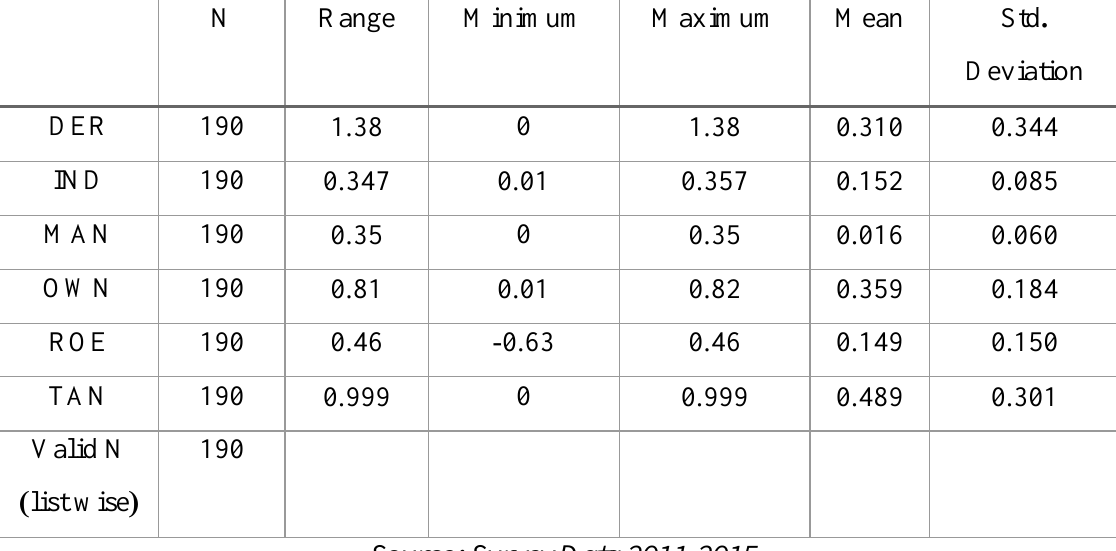
Table 02 - Summary of Descriptive